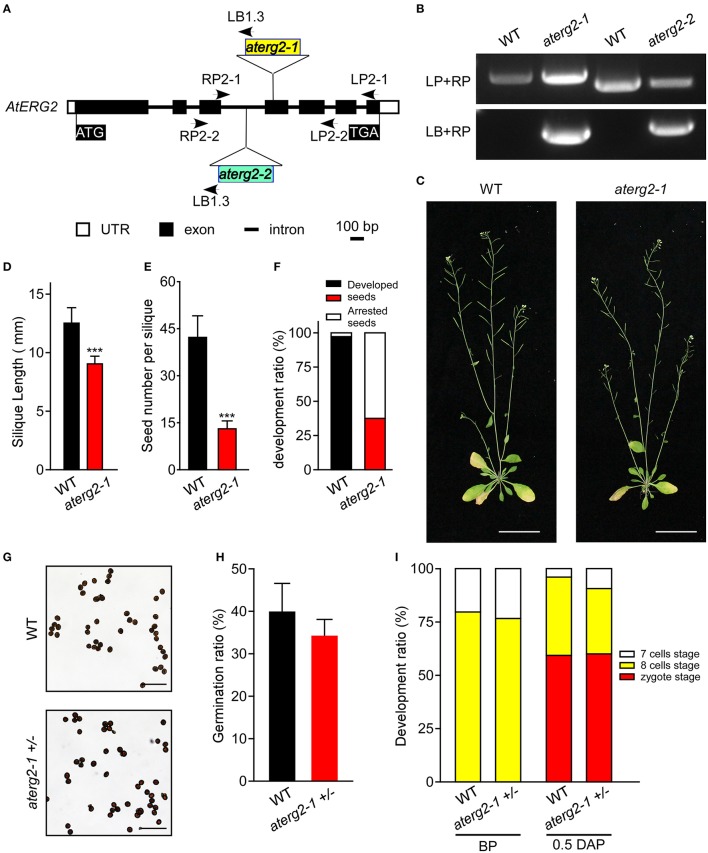
AtERG2 is essential for early seedling development. (A) The schematic diagram for two T-DNA insertions in the Arabidopsis genome of aterg2. Two lines, SALK_032115 (aterg2-1) and SALK_032124 (aterg2-2), were purchased from The Arabidopsis Information Resource (TAIR, http://www.arabidopsis.org/). Open box, UTR; black box, exon; line, intron. Bar = 100 bp. (B) The expression of aterg2-1 and aterg2-2 identified by PCR. Arabidopsis wild-type (WT) was used as the control. LP, LB, and RP primers were the primers used for PCR and are shown in Table S1. (C) The 6-week-old whole aerial parts of the WT and heterozygous line aterg2-1 +/− after planting in soil. Bar = 5 cm. (D) The length of mature siliques from WT and aterg2-1 +/− (n = 60). The values are means ± SD. *** indicates extremely statistically significant values (P < 0.001). (E) The mature seed numbers per silique of WT, aterg2-1, and aterg2-2 plants (n = 60). The values are means ± SD. *** indicates high levels of statistical significance (P < 0.001). (F) The ratio of developed and arrested seeds in WT, aterg2-1, and aterg2-2 plants at 6 DAP (number of siliques = 8). (G) The iodine-staining of mature pollens from WT and aterg2-1 +/−. Bar = 0.2 mm. (H) The germination ratio of mature pollens from WT and aterg2-1 +/−. The pollen number >260. (I) The ratio of developed ovules in WT and aterg2-1 +/− at BP (before pollination) and 0.5-DAP, respectively. The ovule number >150.